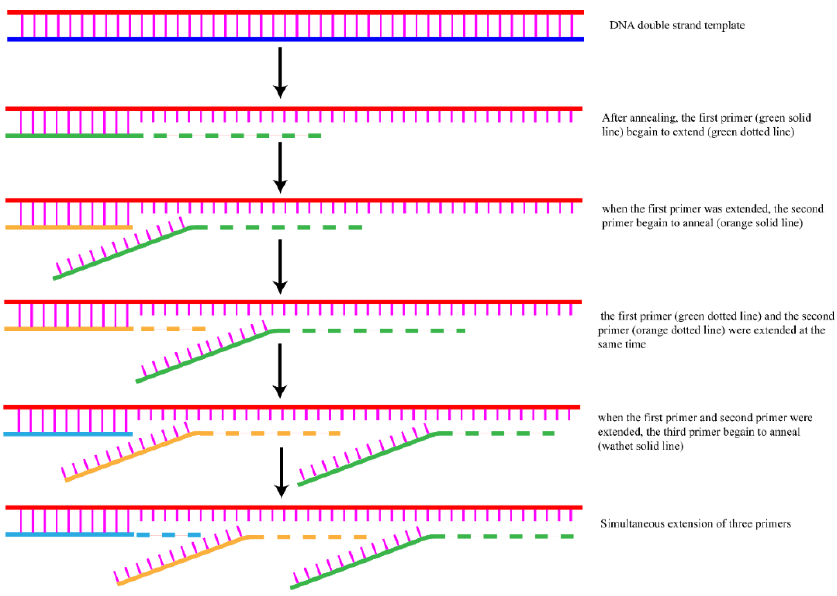
Figure 1. Schematic illustration of enzyme-mediated amplification. Table 1. Geographic origins and hosts of Bursaphelenchus species used in the